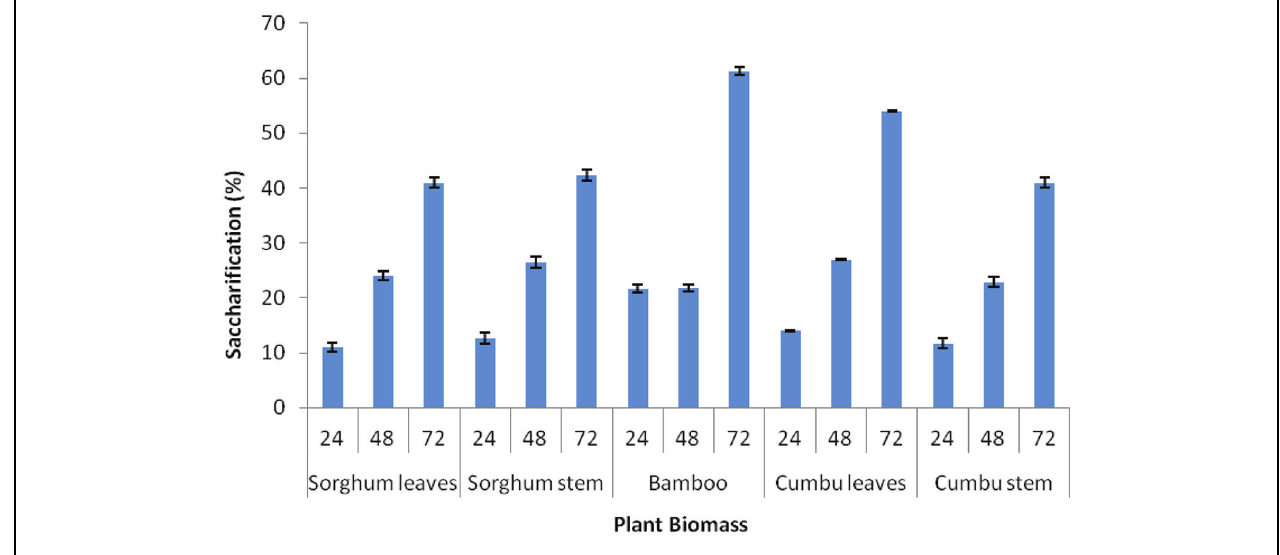
FIGURE 4 | Biomass saccharification potential of Enhydrobacter sp. ACCA2. The strain ACCA2 was inoculated separately with plant biomasses such as sorghum leaf, sorghum stem, bamboo, cumbu leaf and cumbu stem, and allowed for saccharification reaction. Release of reducing sugar was monitored at fixed time intervals and percentage of saccharification was